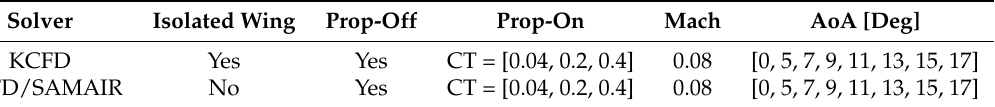
Table 1. Simulation test matrix.